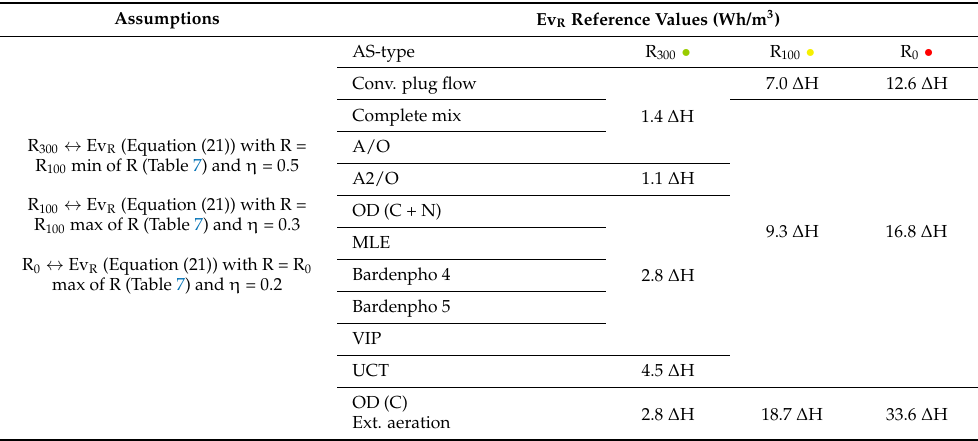
Table 8. The reference values of the energy consumption for the return sludge in the AS